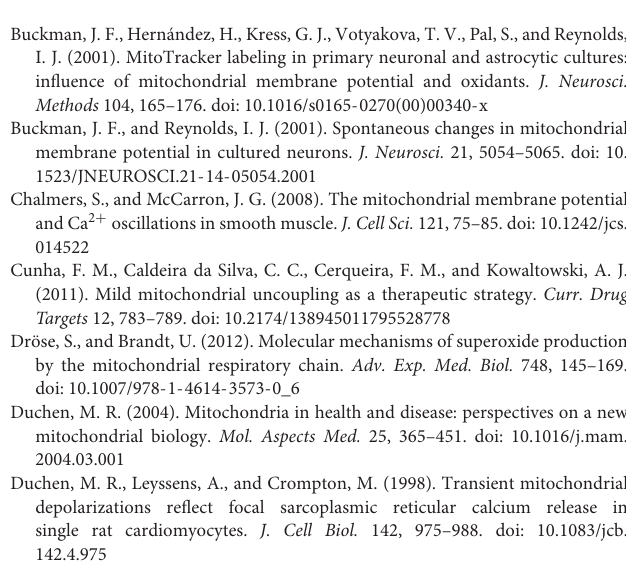
Supplementary Figure 1 | Calibration curve for determining matrix and cytosolic pH from BCECF fluorescence ratio. BCECF fluorescence was measured in the presence of 5 and 30 µ M CCCP for isolated mitochondria and H9c2 cells, respectively, without the addition of malate. (A) Dots show experimental data. The solid line shows the theoretical curve of (F L /F S ) = (A + B × 10 ( 7 - pH ) )/ (C + 10 ( 7 - pH ) ) and is fitted to the experimental data with least-square fitting, where A is 0.045, B is 0.37, and C is 0.042. The dichroic mirror used is U-MWBV (Olympus, Japan). (B) In H9c2 cells, the above-mentioned theoretical curve is fitted to the experimental data with least-square fitting, where A is 0.567, B is 2.40, and C is 0.097. The dichroic mirror used is U-MNIBA (Olympus, Japan). Supplementary Figure 2 | Effects of TMRE concentration and illumination intensity on the transient depolarizations. Frequencies of the transient depolarization were determined in the presence of 1 mM malate. (A) Effects of TMRE concentration on the transient depolarization. (B) Effects of excitation intensity on the transient depolarization. Excitation intensity was changed with the neutral density filters with 12, 25, and 50% transmittance. Supplementary Figure 3 | Effects of ADP on respiration and antimycin A-induced ROS production. (A) Effects of ADP on respiration in the absence of oligomycin. ADP was added to the mitochondrial suspension at 5 mM. (B) Effects of ADP on antimycin A (AA)-induced ROS production in the presence of oligomycin. Mitochondria were incubated with 1 µ M antimycin A for 20 min at 25 ◦ C. Values represent the mean ± SEM ( n = 3). ∗ p < 0.05 vs. control. Supplementary Figure 4 | Effects of CCCP and NH 4 + on H9c2 cells. (A) Effects of CCCP concentration on Cell TMRE in H9c2 cells. (B) Effects of NH 4 + on cytosolic pH in H9c2 cells. Values represent the mean ± SEM ( n > 10). ∗ p < 0.05 vs. 0 µ M CCCP for (A) ; control for (B) . Supplementary Figure 5 | TMRE fluorescence of mitochondria in H9c2 cells. The TMRE fluorescence image of H9c2 cells were obtained by using a 40 × (Uapo40 × /340, NA = 0.9; Olympus), with binning pixels 1 × 1, under computer